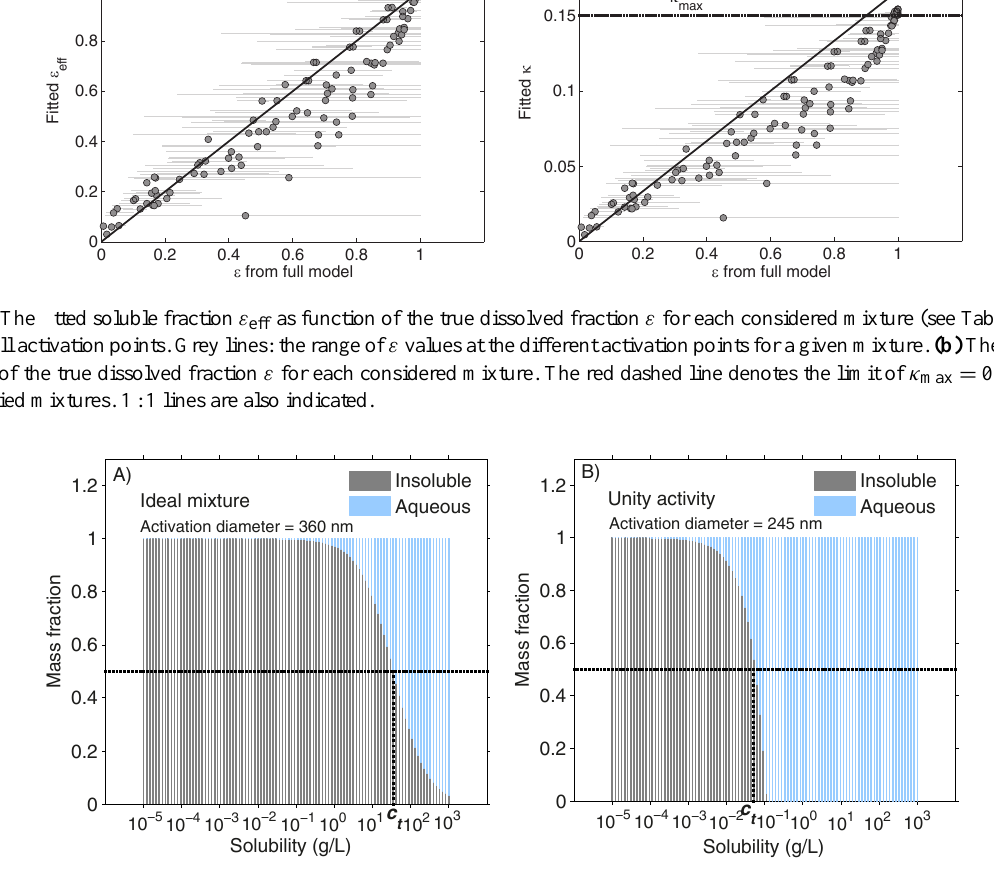
Figure 8. The dissolution behavior of the organic mixture corresponding to distribution 1 with n = 100 and the low solubility range (see Table 2) at the activation point for s c = 0 . 1% (see Fig. 4). The figures depict the distribution of material in each solubility bin between the aqueous and insoluble organic phases for the two different assumptions about the organic-phase activity. c t refers to the 50% point of the partitioning (Eqs. 24 and 25). (a) The ideal organic mixture. (b) The unity activity